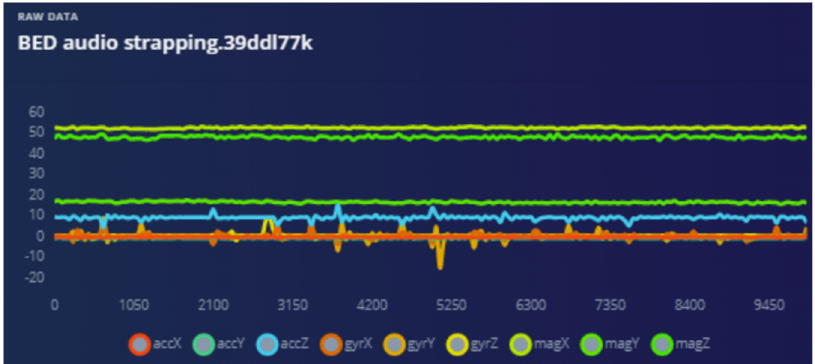
Figure 22. The accelerometer and magnetometer provide positional information instantaneously when disturbed.